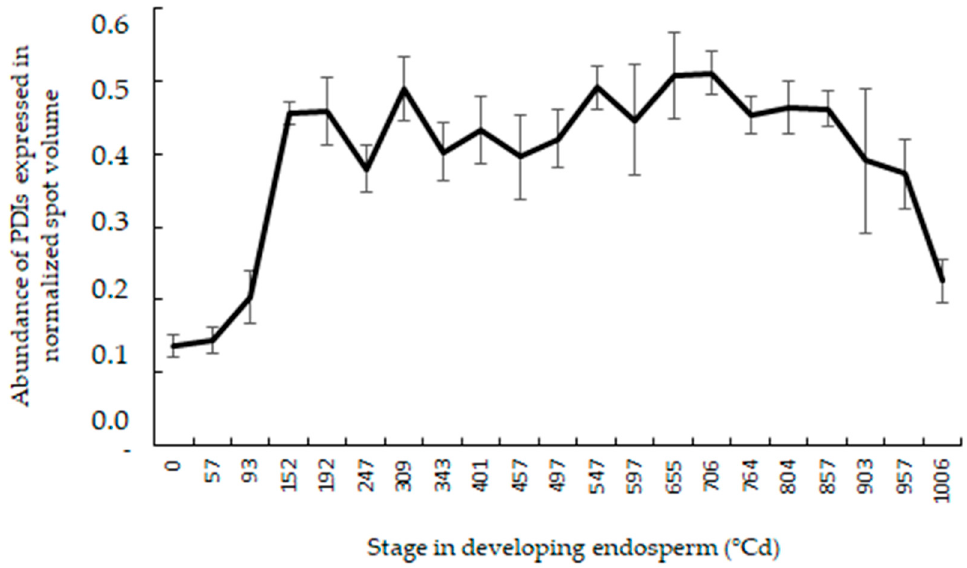
Figure 3. Evolution of the average abundance of eight protein disulfide isomerases (PDIs) ( ± SD) expressed in the endoplasmic reticulum (ER) at 21 stages in developing endosperm (from 0 to 1006 ◦ Cd) of cultivar ”Récital” grown in controlled-temperature environments (computed from [31]).